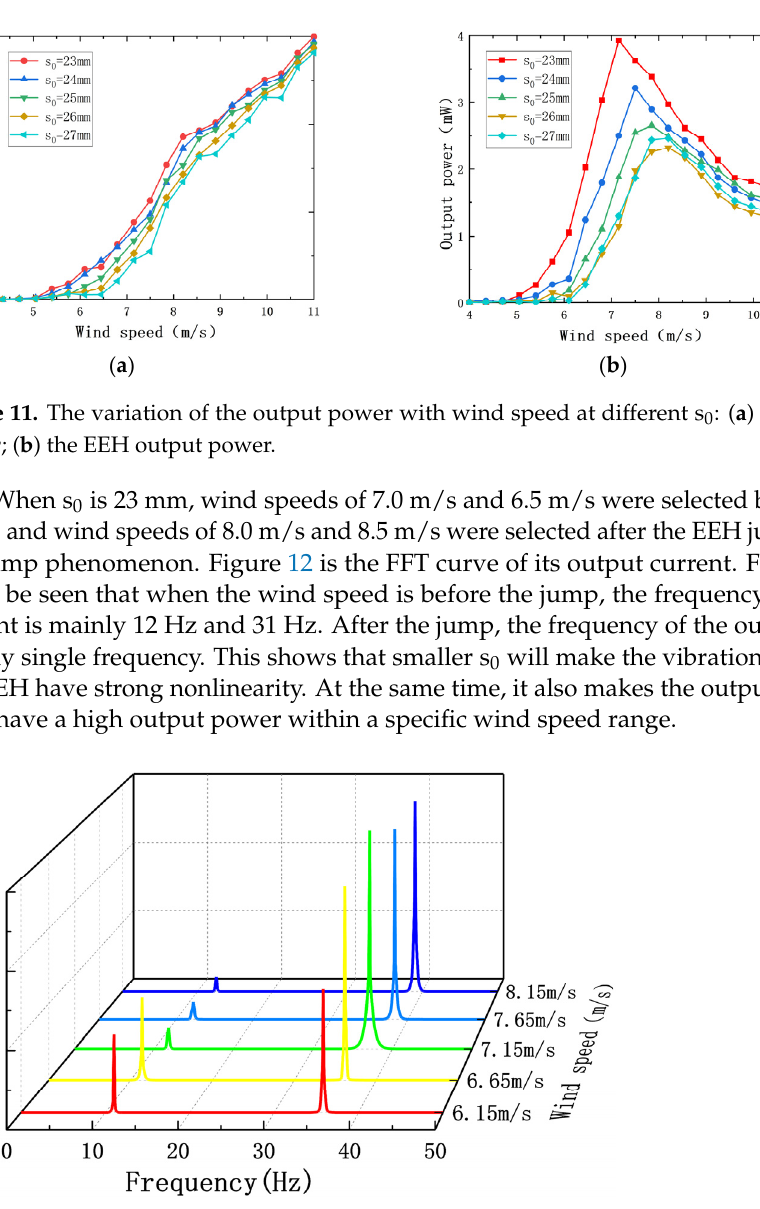
Figure 12. Fourier transform curves of the EEH output current at different wind speeds before and after the jump at s 0 is 23 mm.